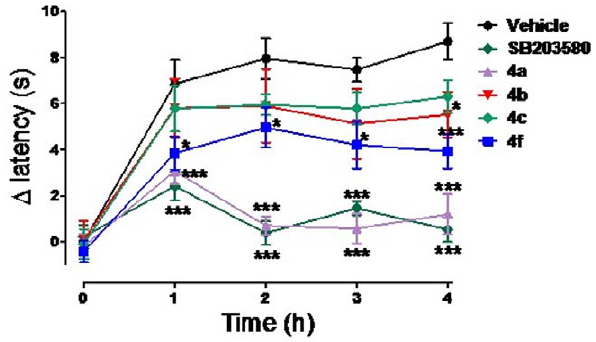
Figure 8. Effects of the NAH derivatives 4a and 4f (100 m mol/ kg, p.o.) on the TNF- a level in carrageenan-injected paws. n=8– 10 animals per group, the test groups were compared to the vehicle control group using student’s t test, *p , 0.05.